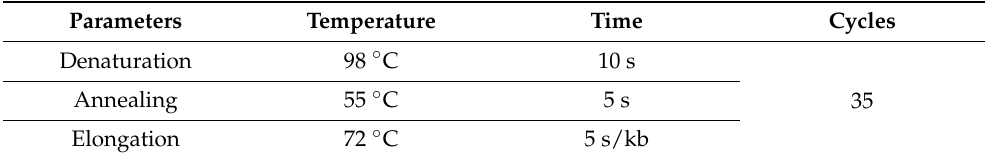
Table 4. PrimeSTAR DNA polymerase PCR